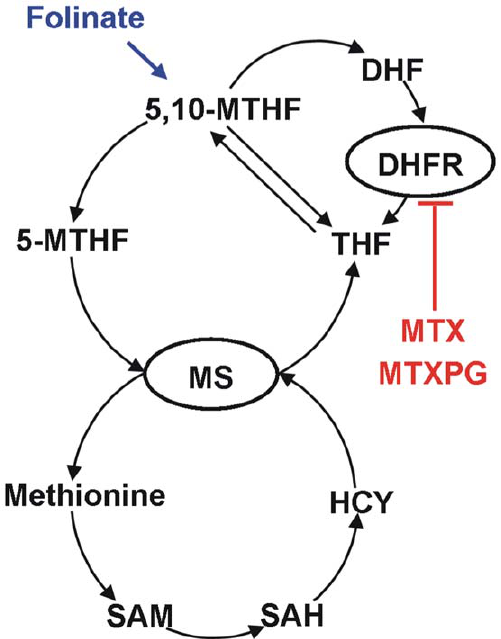
Figure 1. Scheme of the folate-homocysteine pathway (MTX = methotrexate; MTXPG = MTX polyglutamates; DHFR=dihydrofolate reductase; DHF=dihydrofolate; THF=te- trahydrofolate; 5-MTHF = 5-methyl-THF; 5,10-MTHF = 5,10- methylene-THF; HCY = homocysteine; MS = methionine synthase; SAM=S-adenosylmethionine; SAH=S-adenosylho- mocysteine).